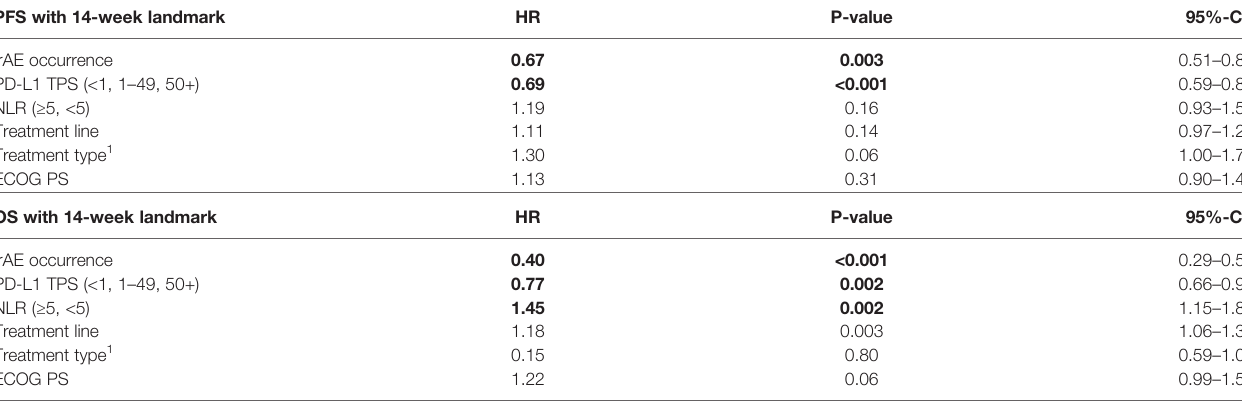
TABLE 3 | Univariable analysis of progression-free and overall survival according to occurrence of irAE in NSCLC. PFS with 14-week landmark